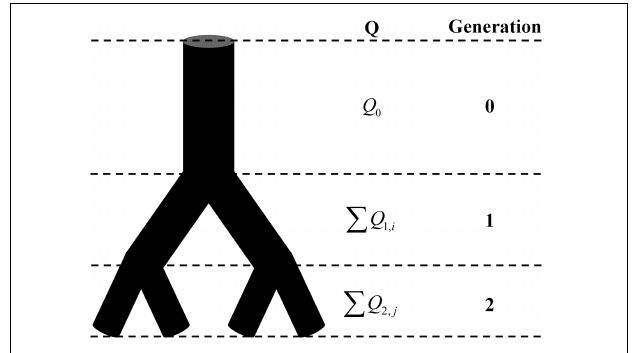
FIGURE 1 | The schematic of the conservation of flow at different generations. Q is the blood flow and Q 0 = P Q 1 , i = P Q 2 , j .